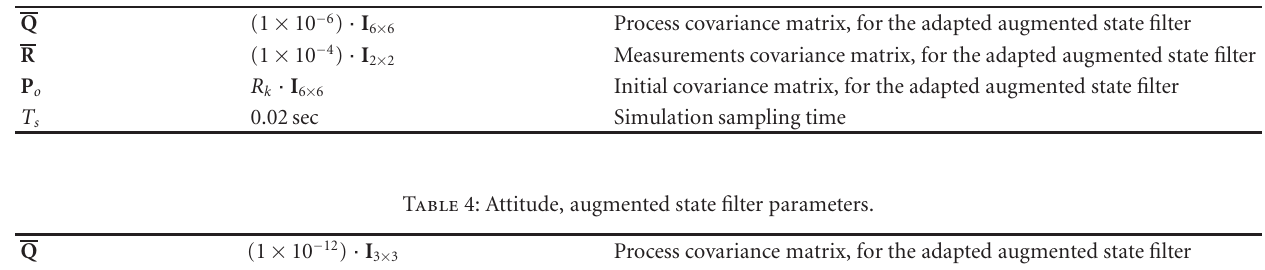
Table 3: Position, augmented state filter parameters.